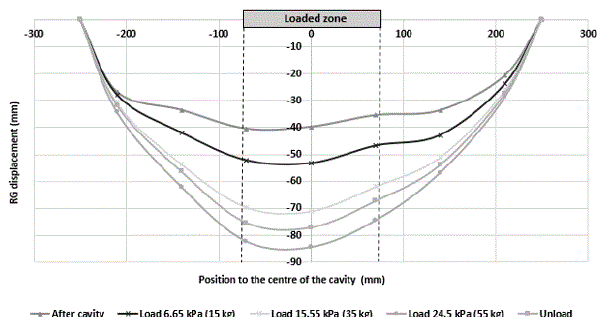
Figure 7. Evolution of the RG displacements during loading and unloading.